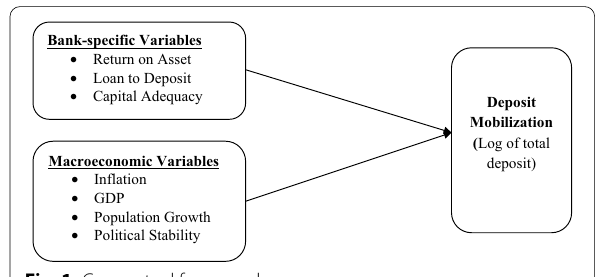
Fig. 1 Conceptual